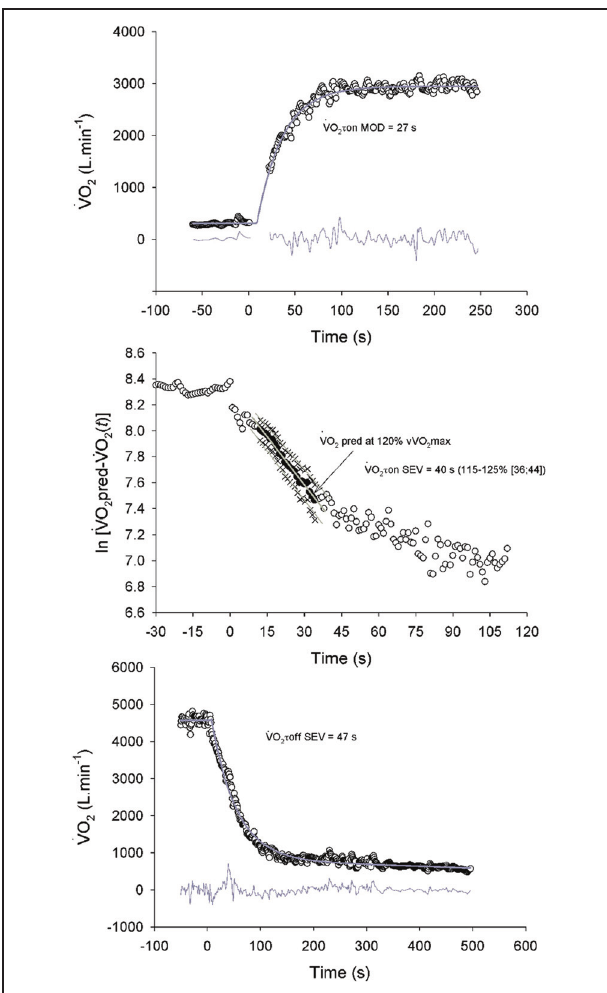
FIGURE 2 | Example of oxygen uptake ( ˙ V O 2 ) kinetics determination in a representative subject at exercise onset (upper and mid panel) and during exercise recovery (lower panel). ˙ V O 2 τ on MOD and ˙ V O 2 τ on SEV are the time constants of the primary component of the pulmonary ˙ V O 2 kinetics at exercise onset in the moderate and severe exercise intensity domain, respectively. ˙ V O 2 τ off SEV is the time constants of the primary component of the pulmonary ˙ V O 2 kinetics after exercise performed in the severe intensity domain. The bottom gray line in the upper and lower panels represents the